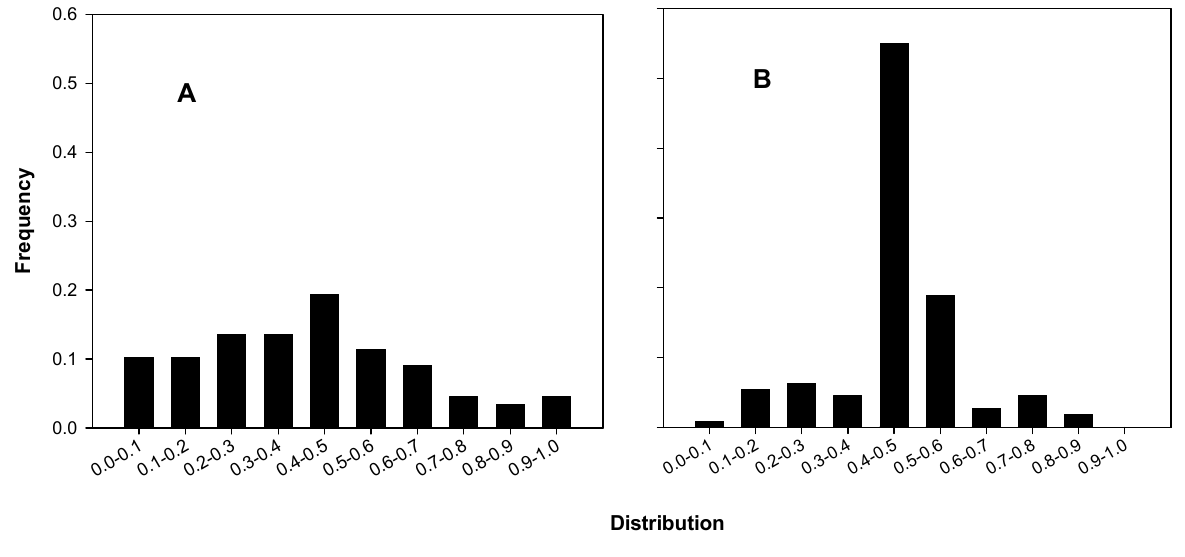
Figure 3. Mid-ratio distributions for colony counts. ( A ) B’s and C’s colonies, 29 of 88 in the 0.4–0.6 interval, 35.4 ± 5.19 expected ( p ~ 0.91); ( B ) A’s colonies, 83 of 111 in